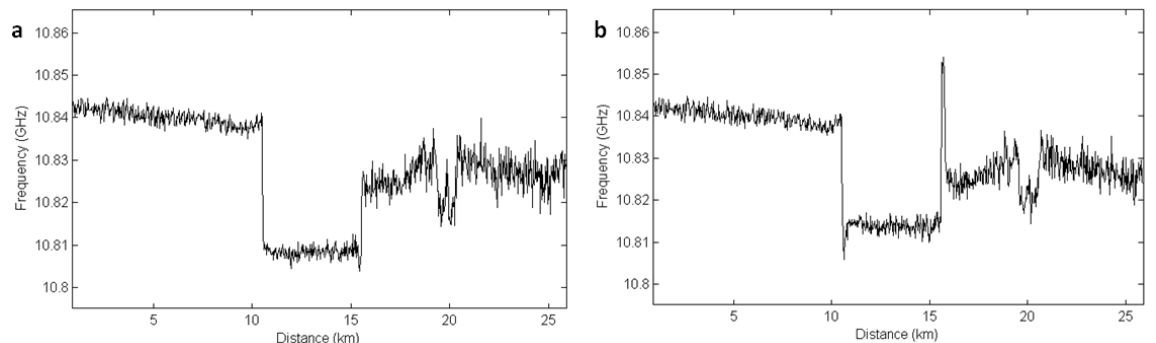
Figure 10. Brillouin frequency shift along the sensing channel 1 ( a ) and the sensing channel 2 ( b